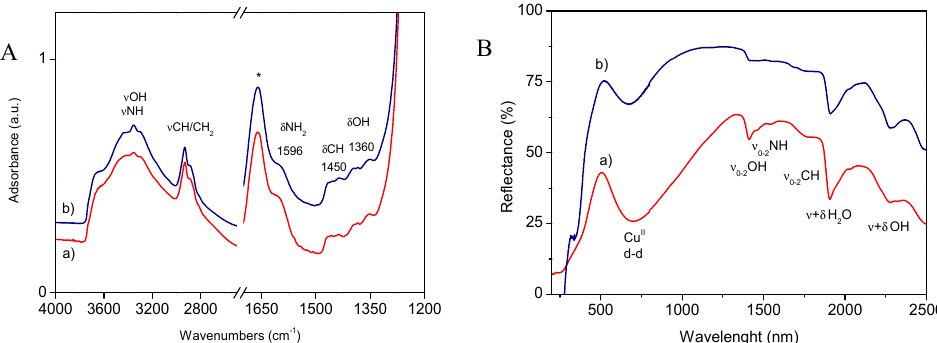
Figure 5. Infrared ( A ) and diffuse reflectance UV-Vis ( B ) spectra of (a) Si-TriAm-CD-Cu; (b) Si-TriAm-CD-Cu-exhaust. Before infrared measurements samples were outgassed at 80 °C to remove adsorbed water and impurities. Sample Si-TriAm-CD-Cu-exhaust was diluted in Teflon for Diffuse-Reflectance (DR) UV-Vis measurement. The corresponding curve was arbitrarily normalized to the intensity of the overtone/combination modes of the support (X 2.5). The peak labeled with * can be related to DMF residual solvent.